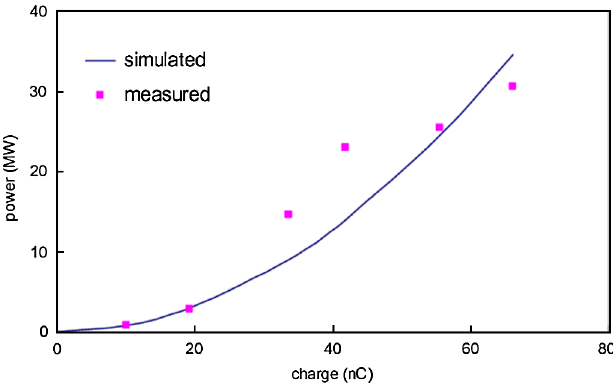
FIG. 10. Experimental setup for the beam tests.